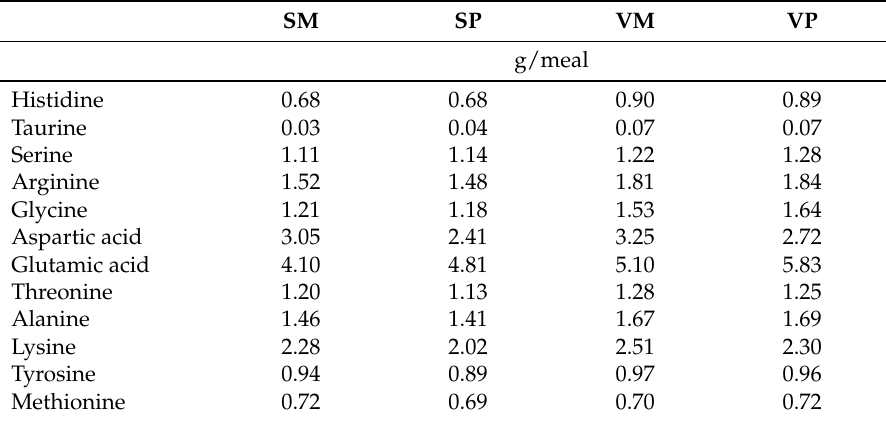
Table 2. Amino acids composition of the four test meals 1